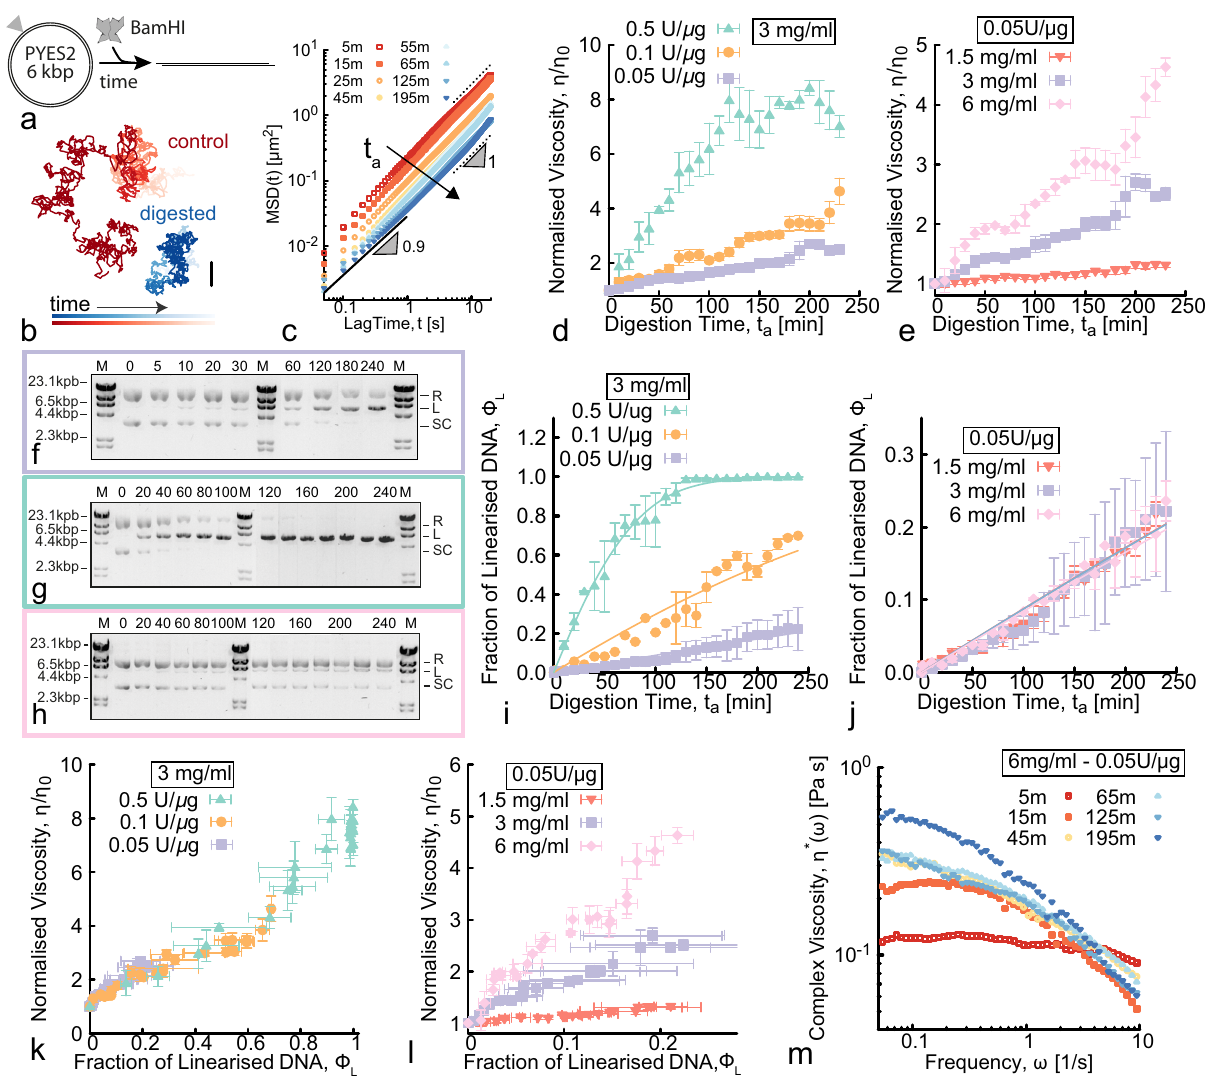
Fig. 1 | RE-mediated linearisation drives an increase of viscosity of entangled fl uids of circular DNA. a Digestion of 5.9kbp circular (supercoiled and ring) pYES2 by restriction enzyme BamHI triggers an irreversible architectural change from circular to linear topology. b Representative particle trajectories from microrheology in intact (control, red) and digested (blue) solutions. Shading from dark to light indicates increasing tracking time. Scale bar is 1 μ m. c Mean-squared displacements (MSD) versus lag time t at different digestion times t a (shown in minutes in the legend) after the addition of BamHI to pYES2 fl uids (see Supple- mentary Fig. 1). The arrow points in the direction of increasing digestion times t a . Black dotted and solidlines represent power-law scaling MSD~ t α for free diffusion ( α =1) and subdiffusion ( α <1). d , e Normalised viscosity as a function of digestion time t a obtained from microrheology for DNA fl uids with ( d ) varying RE:DNA stoichiometries at 3mg/ml, and ( e ) varying DNA concentrations at fi xed RE:DNA